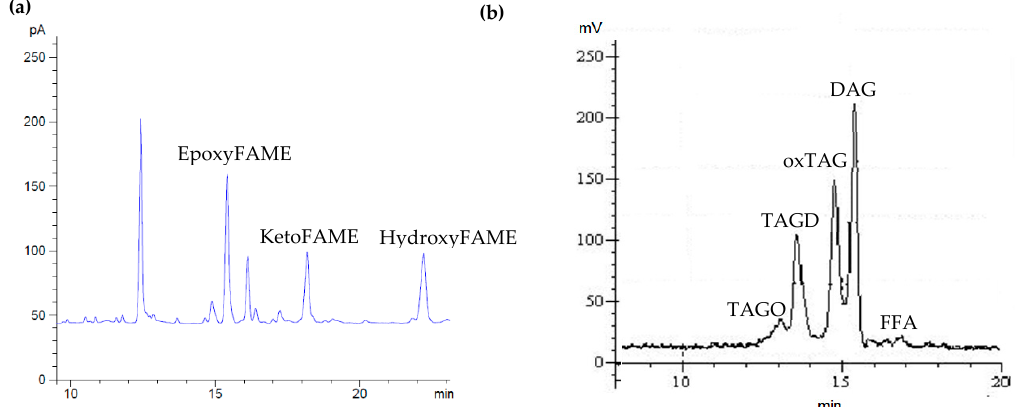
Figure 2. ( a ) Sample gas chromatograph (GC) chromatogram for the determination of epoxy, keto, and hydroxy acids and ( b ) sample high performance size exclusion chromatography (HPSEC) chromatogram for the determination of polar fraction distribution (TAGO: Triacylglycerol oligomer; TAGD: Triacylglycerol dimer; oxTAG: Monomeric oxidized triacylglycerol; DAG: Diacylglycerol; and FFA: Free fatty acids).